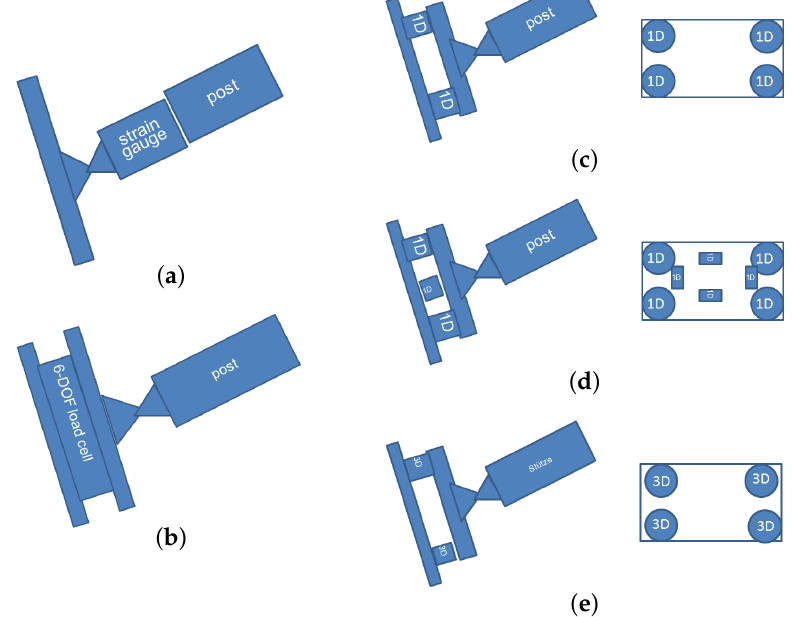
Figure 4. Different possible setups to measure 6-DOF at a post base. ( a ) Instrumented steel post; ( b ) single 6-DOF load cell; ( c ) four one-dimensional load cells and ( d ) with additional orthogonal load cells for plate parallel forces; ( e ) four triaxial load